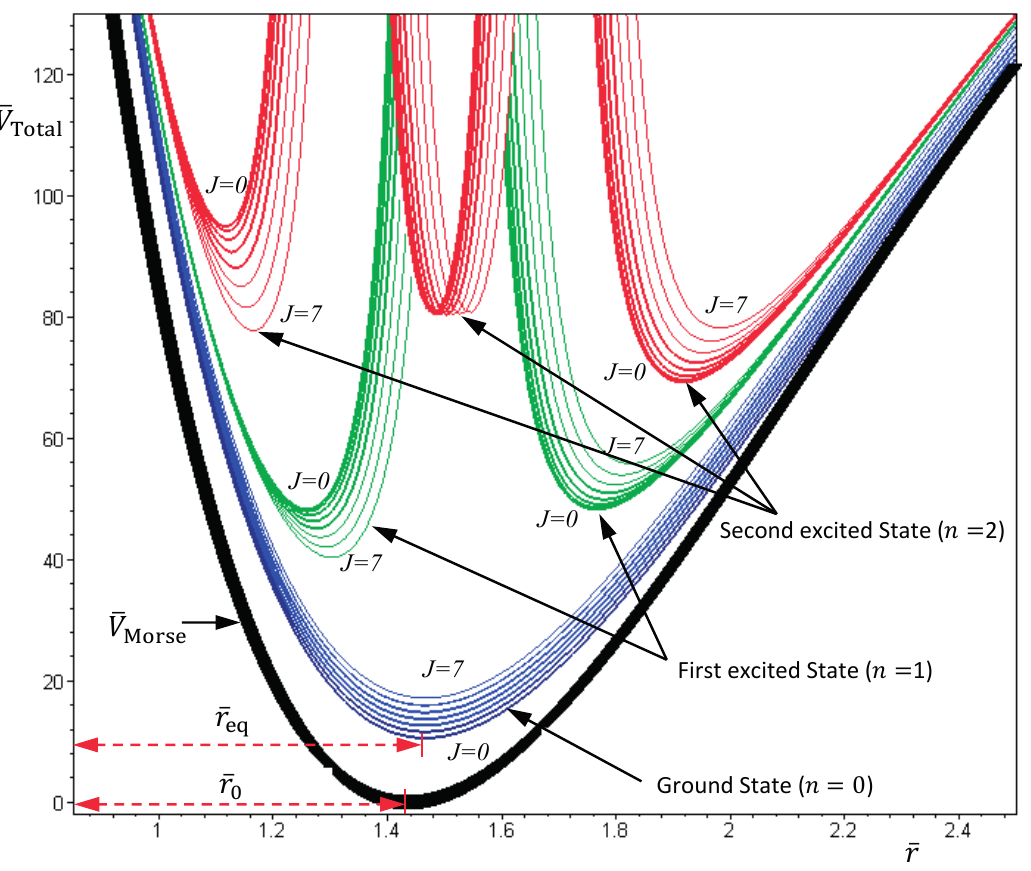
with respect to the two quantum numbers Figure 4. The variation of the total potential (cid:1848) (cid:2904)(cid:2925)(cid:2930)(cid:2911)(cid:2922) of (cid:1848) correspond to the equilibrium bond lengths, and (cid:1866) and J . The lowermost points (cid:1870)̅ (cid:2915)(cid:2927) (cid:2904)(cid:2925)(cid:2930)(cid:2911)(cid:2922) at (cid:1870)̅ correspond to the force constants of the molecule. This figure the curvatures of (cid:1848) (cid:2904)(cid:2925)(cid:2930)(cid:2911)(cid:2922) (cid:2915)(cid:2927) schematically illustrates how the bond length and the force constant change due to the change of quantum